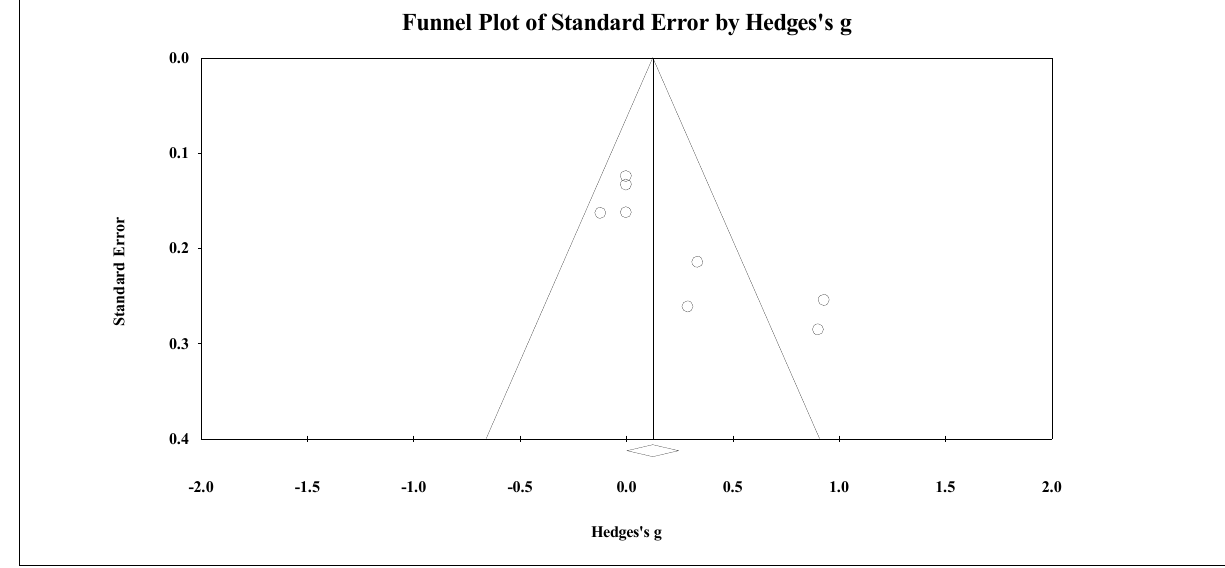
Figure 7. Funnel plot for changes in total body bone mineral density in untrained adults after a training program based on soccer small-sided games. White circles: observed studies. Table 7. Summary of the included studies and results of spine BMD before and after the intervention.